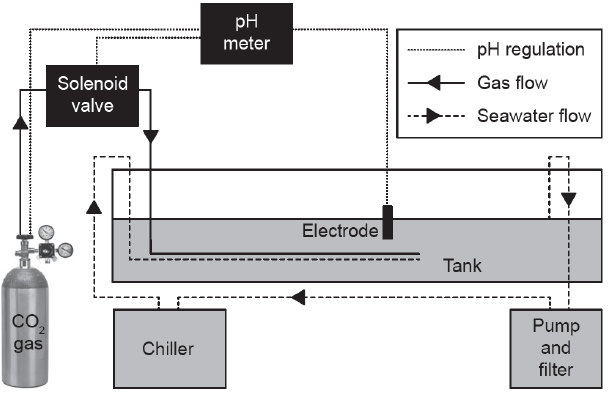
Figure 1Schematic of one OA simulation unit. Dashed lines indicate gas flow, solid lines indicate seawater 2 Figure 1. Schematic of one OA simulation unit. Solid lines indicate flow, and dotted lines indicate electrical connections between components of pH regulation apparatus. 3 gas flow, dashed lines indicate seawater flow, and dotted lines in- dicate electrical connections between components of pH regulation